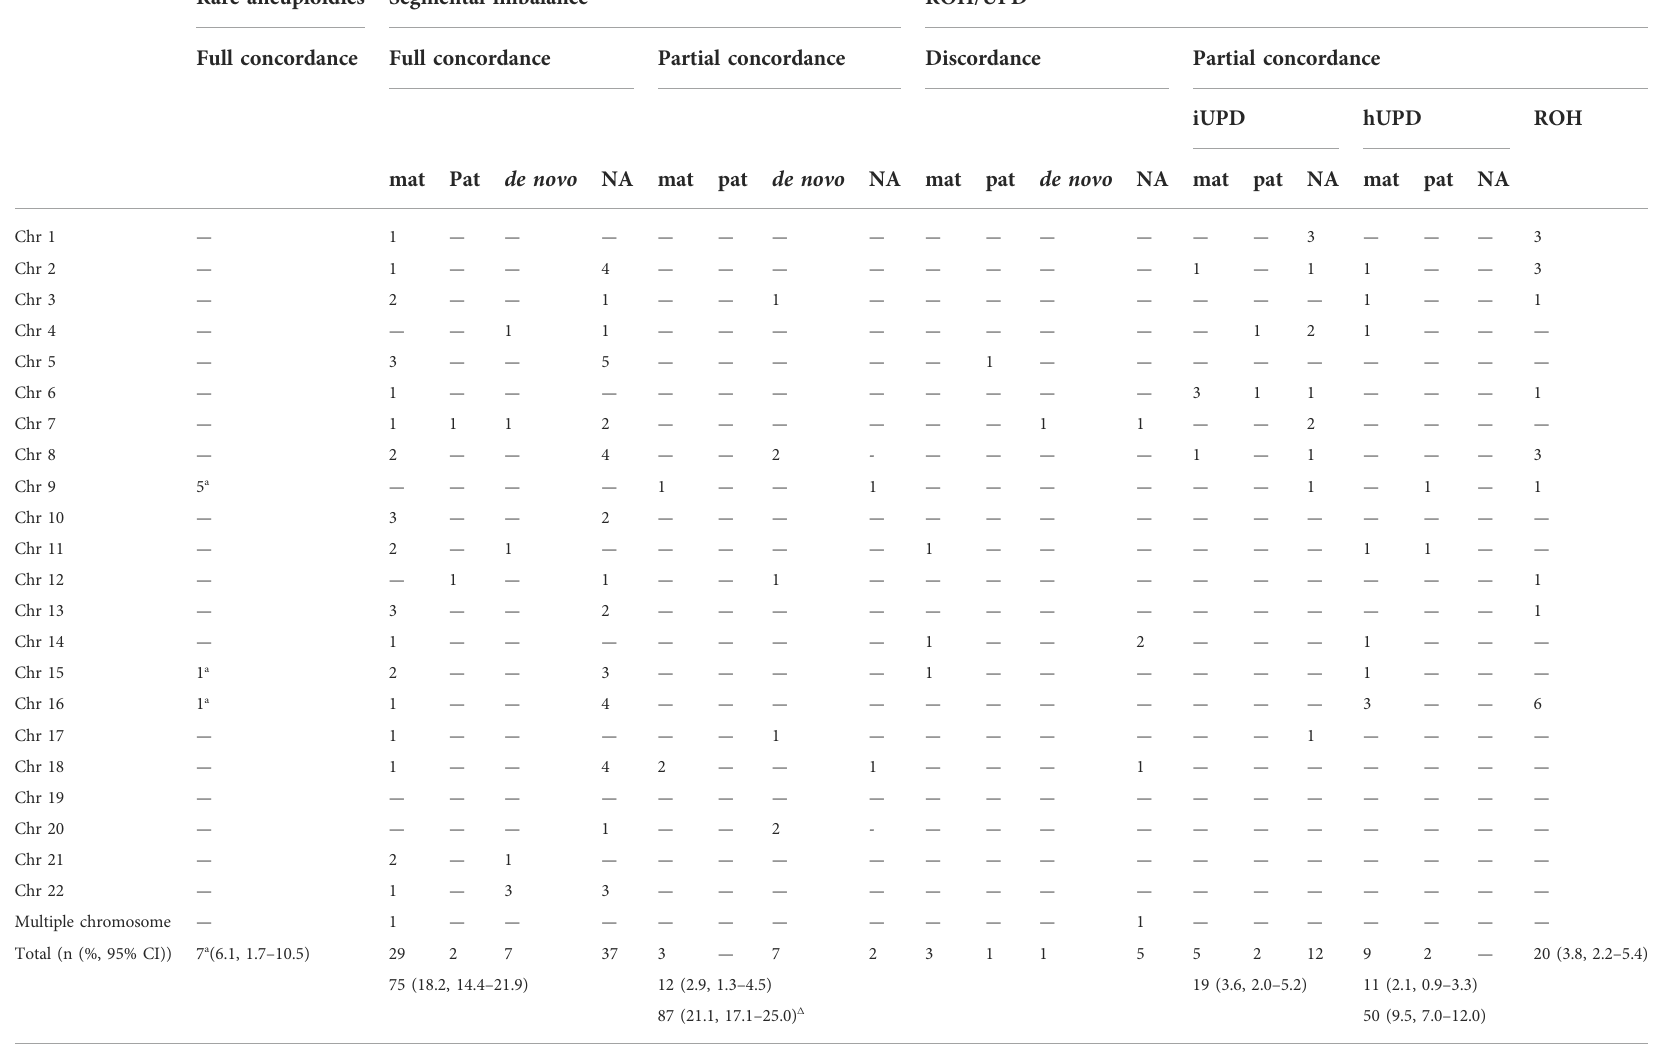
TABLE 2 Concordance between the RCAs detected by NIPT and consecutive CMA